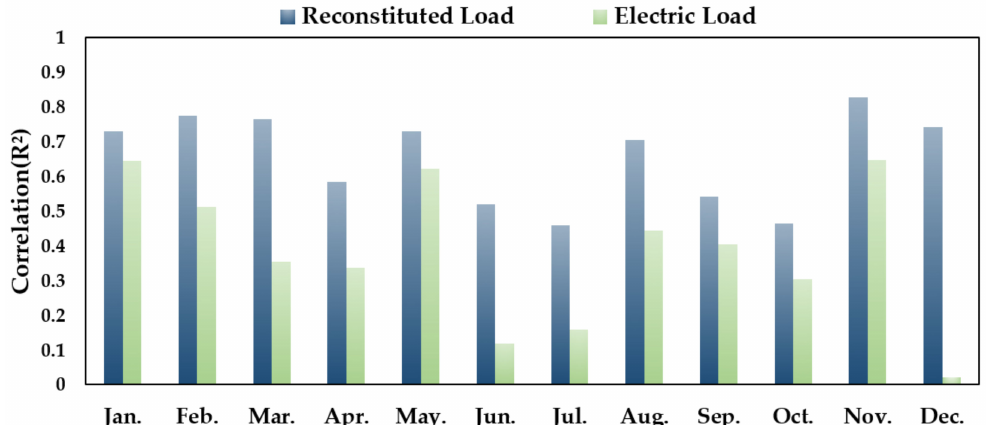
Figure 8. The comparison of the correlation between electric load, reconstituted load and temperature in